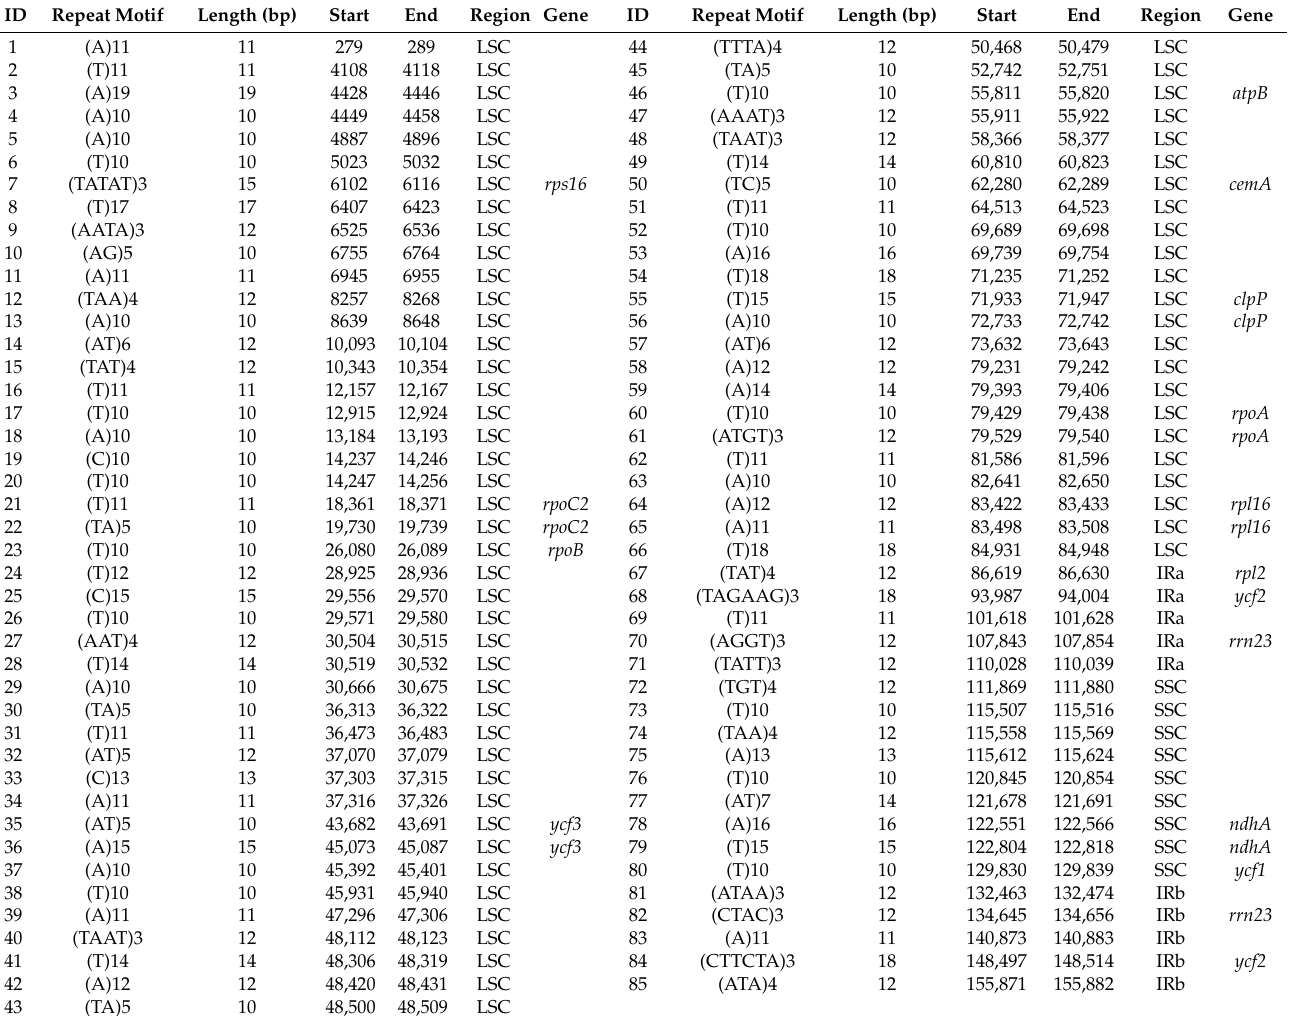
Table 4. Simple sequence repeats (SSRs) in the Rosa chinensis var. spontanea chloroplast